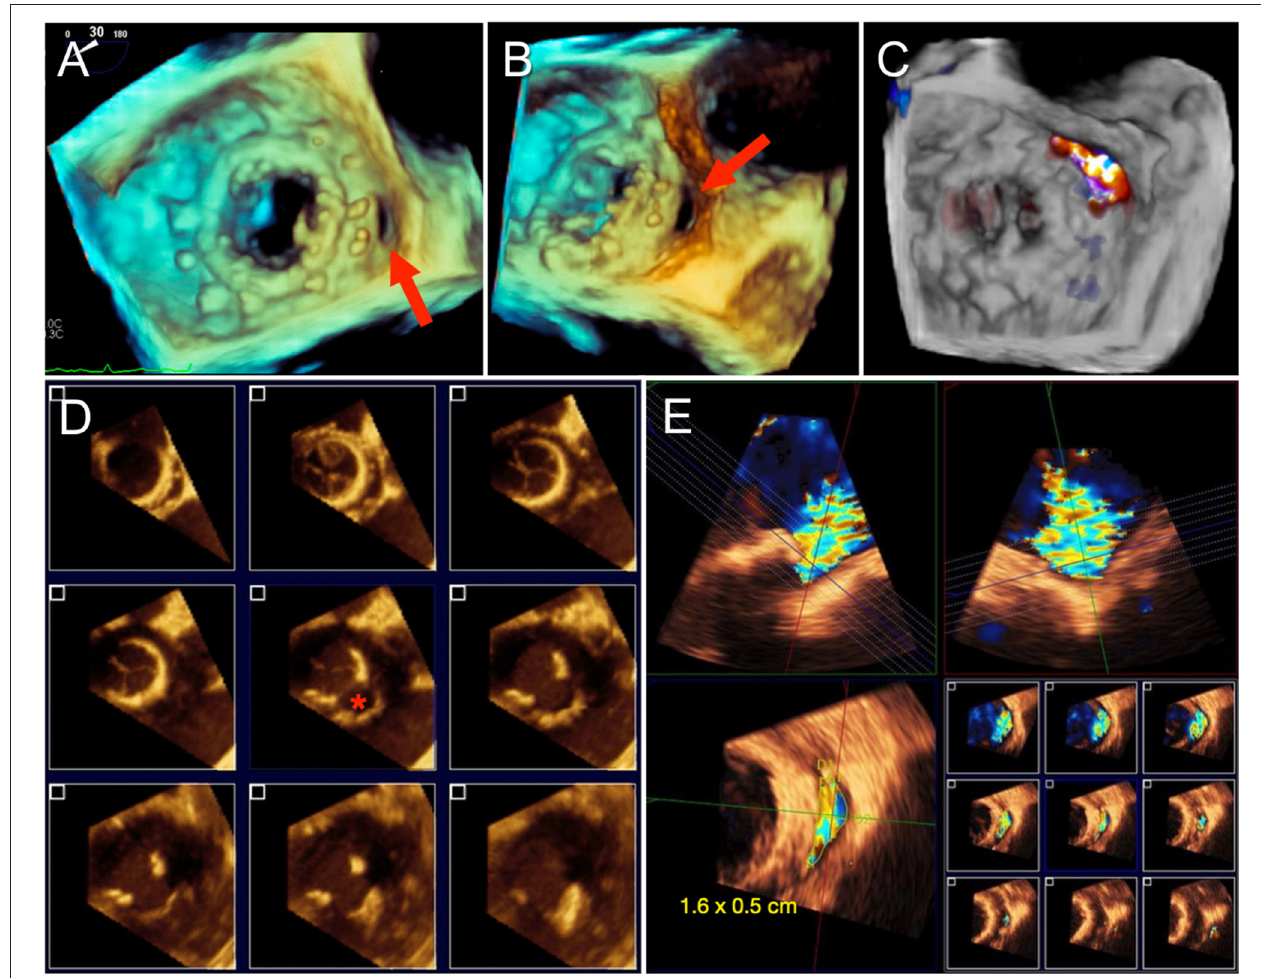
FIGURE 2 | Paravalvular mitral regurgitation assessment by TEE. (A) 3D en face “surgeon’s view” of a mitral bioprosthesis demonstrates a gap along the posteromedial aspect, corresponding to a paravalvular defect. (B) Rotation of the 3D volume improves visualization of the paravalvular defect. (C) Color Doppler confirms regurgitant flow through the defect and no other areas of paravalvular leak (PVL). Sizing of PVL by TEE can be difficult due to irregularity in the shape of the defect and dropout artifact, as shown in (D) , and is best measured with color Doppler to delineate the regurgitant PVL jet and avoid overestimation (E)